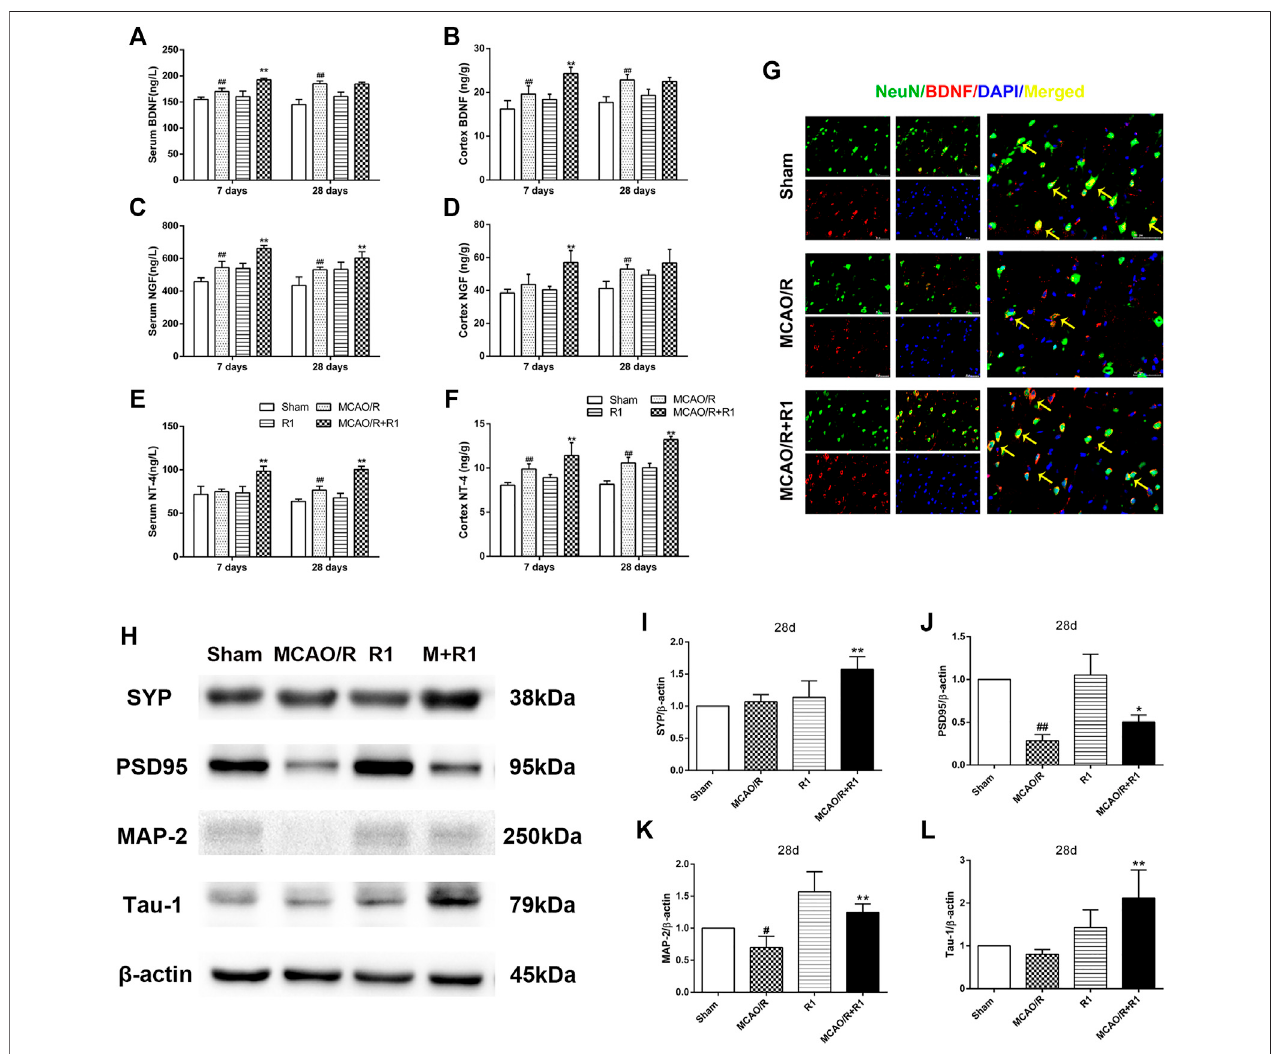
FIGURE 6 | R1 increases neurotrophic factor expression and restores disrupted neural synaptic function after ischemic stroke. The serum and cortex tissue levels of neurotrophic factors, such as BDNF (A, B) , NGF (C, D) , and NT-4 (E, F) were detected by ELISA. (G) Representative images of the infarction area costained with antibodiesagainstBDNF(red)andNeuN(green)onday28afterR1treatment,yellowarrowsindicateNeuN-positiveneuronsexpressedBDNF,DAPI(blue)indicatesthe nucleus,Scalebar (cid:1) 50 μ m.Representativeimagesofimmunoblotting (H) andquanti fi cationoftherelativeproteinlevelsofSYN (I) ,PSD95 (J) ,MAP-1 (K)